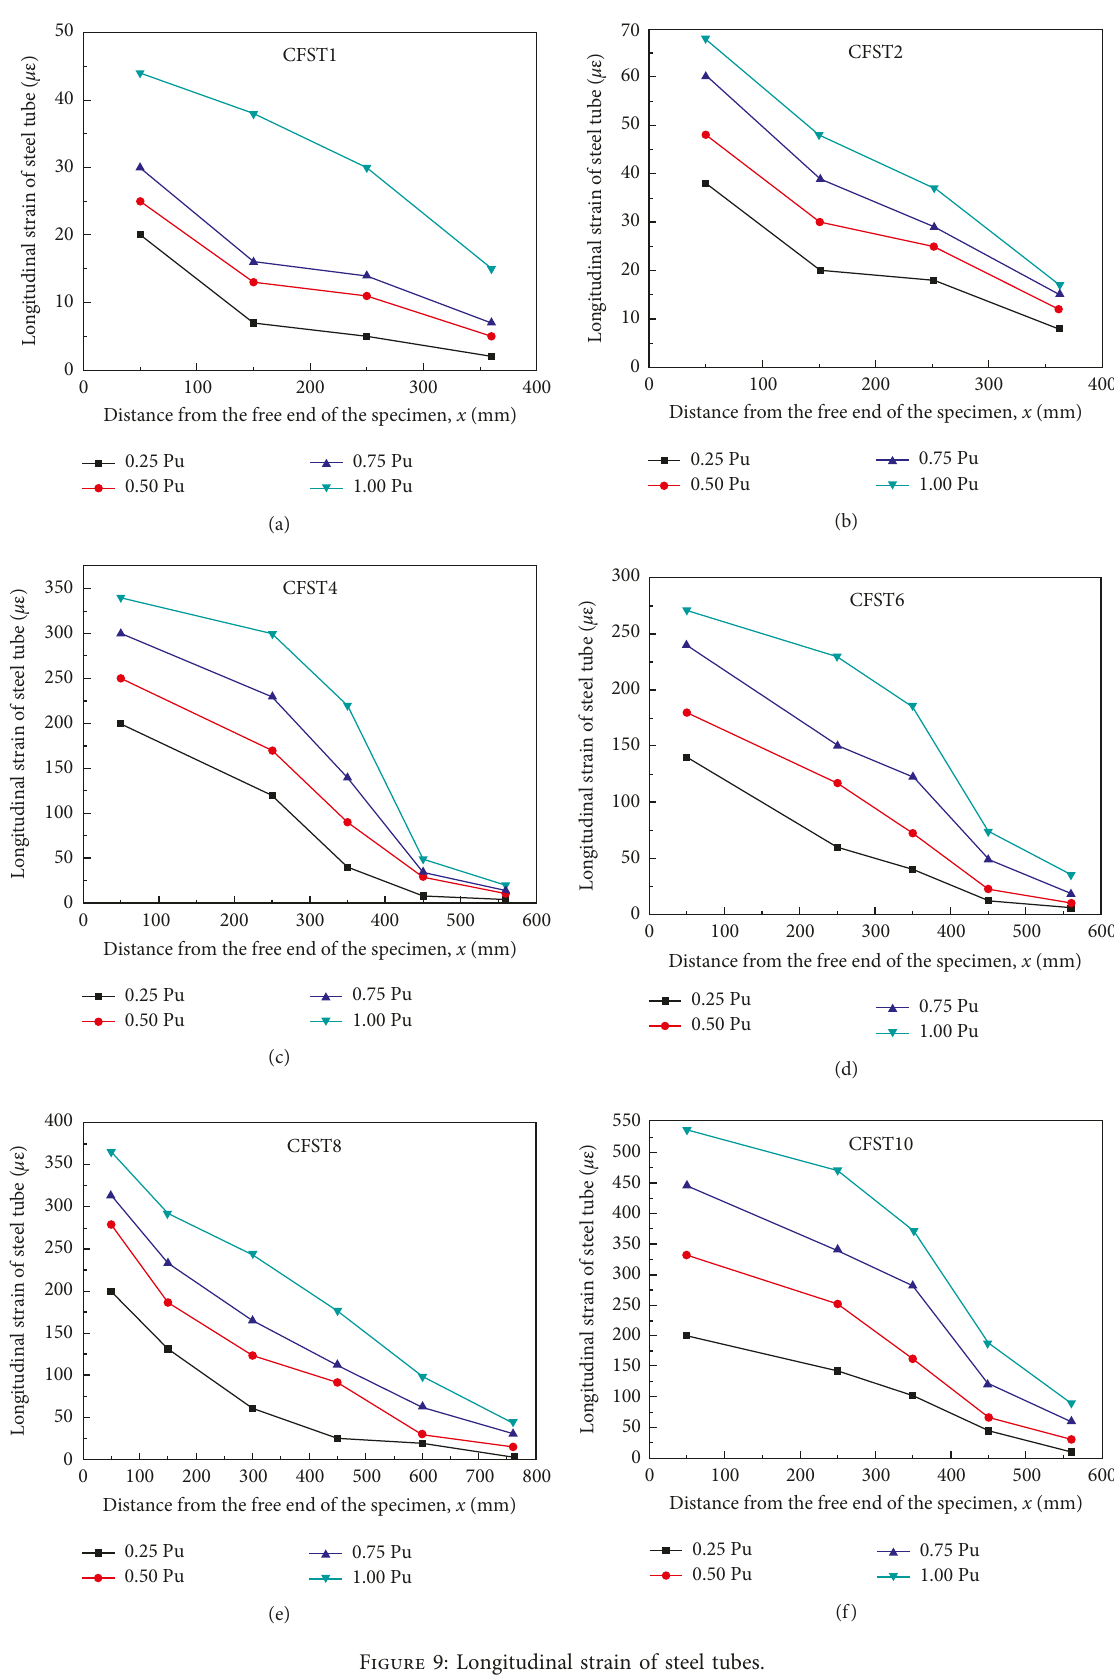
Figure 9: Longitudinal strain of steel